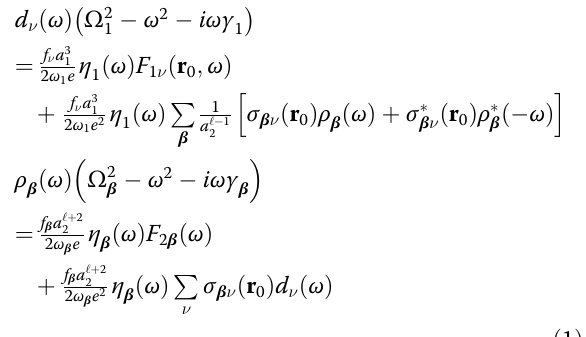
ψ are the characteristic phase lag parameters of the NP 1, β plasmons and Mie resonances, respectively. Numerical